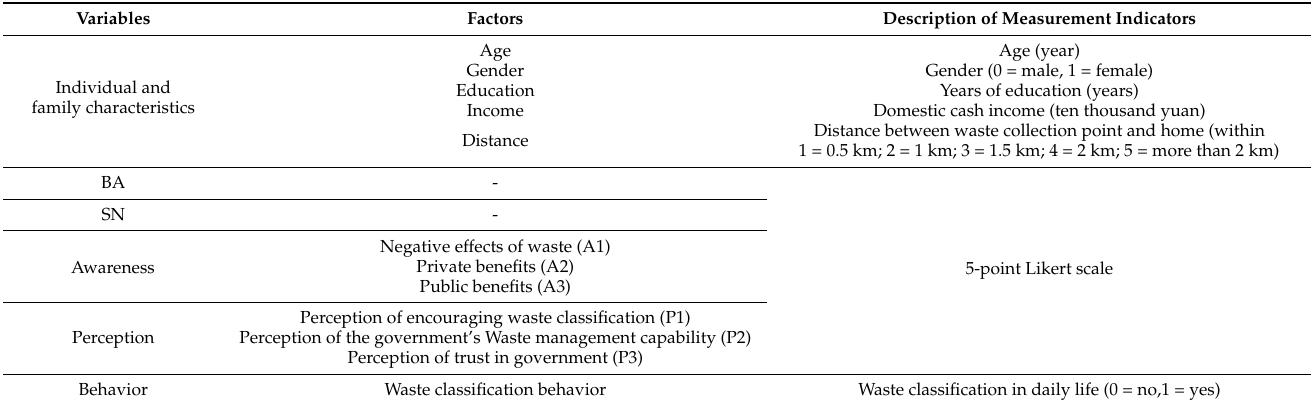
Table 1. Questionnaire composition and measurement